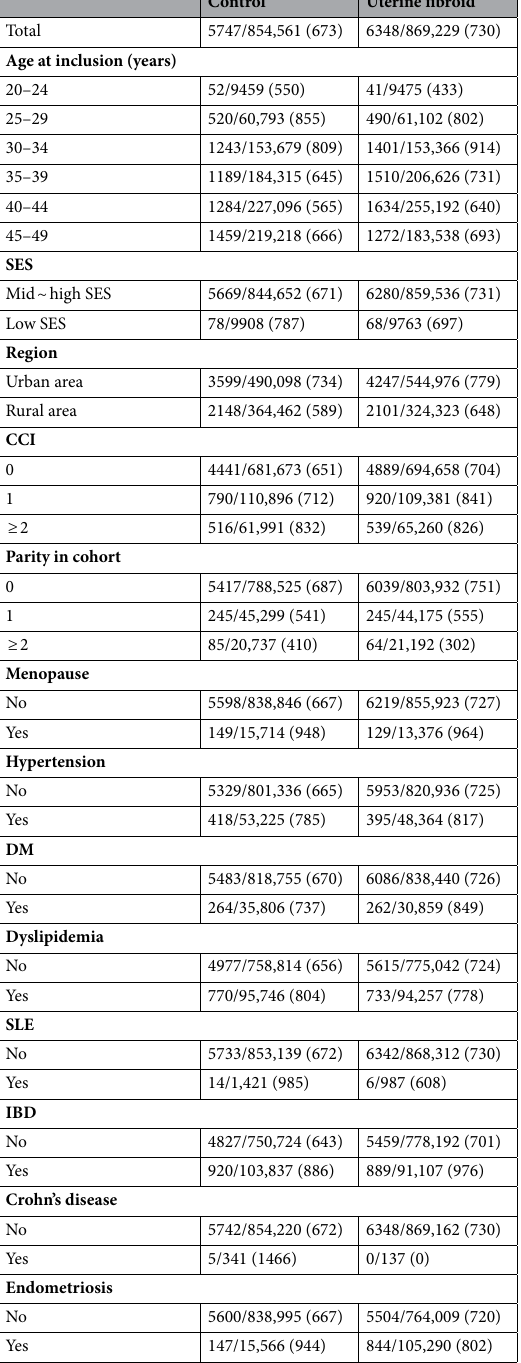
Table 4. Case/person-years of total thyroid disease in participants with or without myomectomy. CCI Charlson comorbidity index, DM diabetes mellitus, IBD irritable bowel syndrome, SES socioeconomic status, SLE systemic lupus erythematosus. Data are expressed as the case/person-years (case/100,000